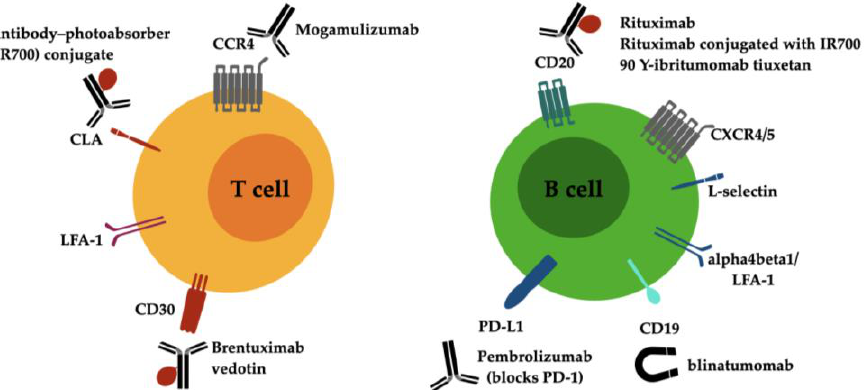
Figure 1. Drug targets on malignant lymphocytes of T and B cell cutaneous lymphoma and current antibody-directed treatment options. Abbreviations: CCR4 C-C chemokine receptor type 4, CD, cluster of differentiation; CLA, cutaneous lymphocyte antigen; CXCR4/5, C-X-C chemokine receptor type 4/5; LFA-1, lymphocyte function-associated antigen 1 (alphaLbeta2 integrin).